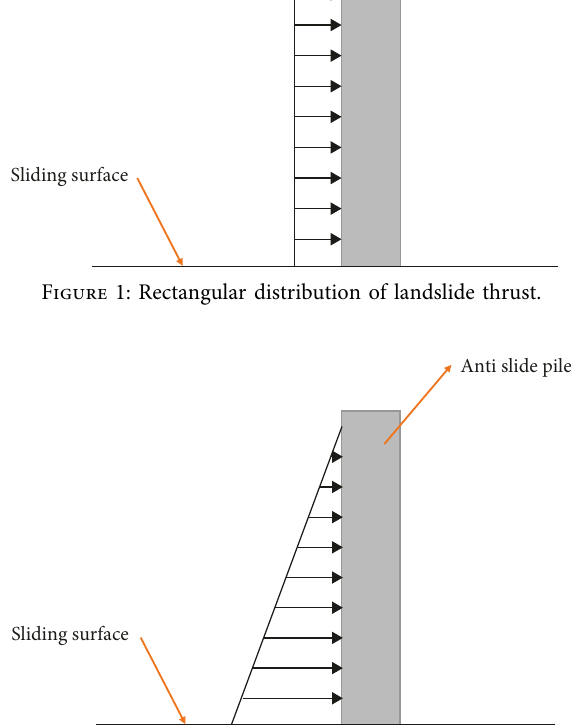
Figure 2: Triangular distribution of landslide thrust.